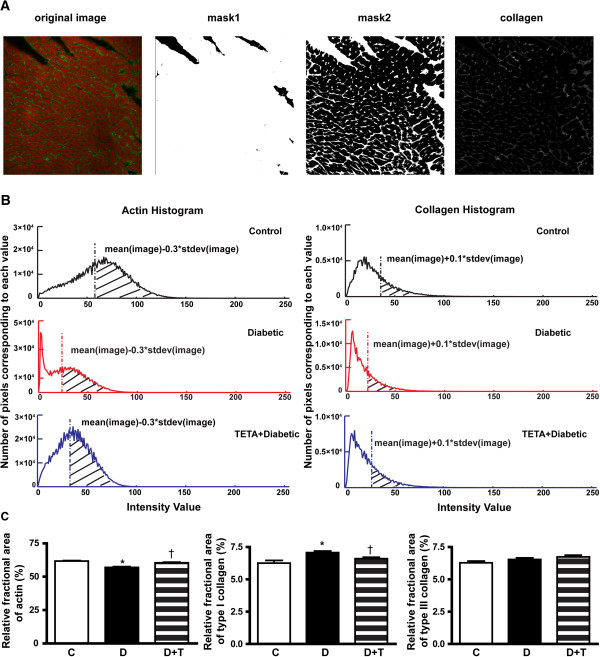
Quantification of collagen and F-actin. Quantification of collagen and F-actin were based on signal thresholding of matched LV endocardial areas from each group (n = 7 per group). To avoid possible effects of orientation and origin of the muscle fibres on the quantification, three transverse optical sections per animal were analyzed. Results have been expressed as percentages of corresponding cross-sectional areas. (A) A representative image illustrating application of the signal thresholding procedure. Mask1 eliminated the unlabelled area; mask2 additionally removed the F-actin labelled area. (B) Histogram of representative images from the three experimental groups showing the thresholds used for quantification. The criteria used for the thresholding process were maintained the same for each of the three experimental groups. The threshold setup for quantifying F-actin labelling was based on both the original image and the image following application of mask1. The threshold setup for quantifying collagen labelling was based on both the original image and the image after application of both mask1 and mask2. Shadowed areas represent signals used for quantification. (C) Results show that diabetic rats had increased type-I collagen content compared to controls (Diabetic: 7.1 ± 0.1% area; Control: 6.2 ± 0.2% area, P = 0.003), and TETA prevented this increase by retaining normal values (TETA-treated diabetic: 6.6 ± 0.1% area, P = 0.008). Diabetic rats also developed lowered F-actin content compared to control rats (Diabetic: 56.9 ± 0.6% area; Control: 61.7 ± 0.4% area, P < 0.0001); whereas, TETA-treatment prevented the lowering of F-actin values (TETA-treated diabetic: 60.4 ± 0.5% area, P < 0.0001). Type-III collagen did not differ significantly between groups. Data are means ± SEM, one-way ANOVA with post-hoc Tukey’s Multiple Comparisons test. * C vs D; † D vs D + T; P < 0.05.